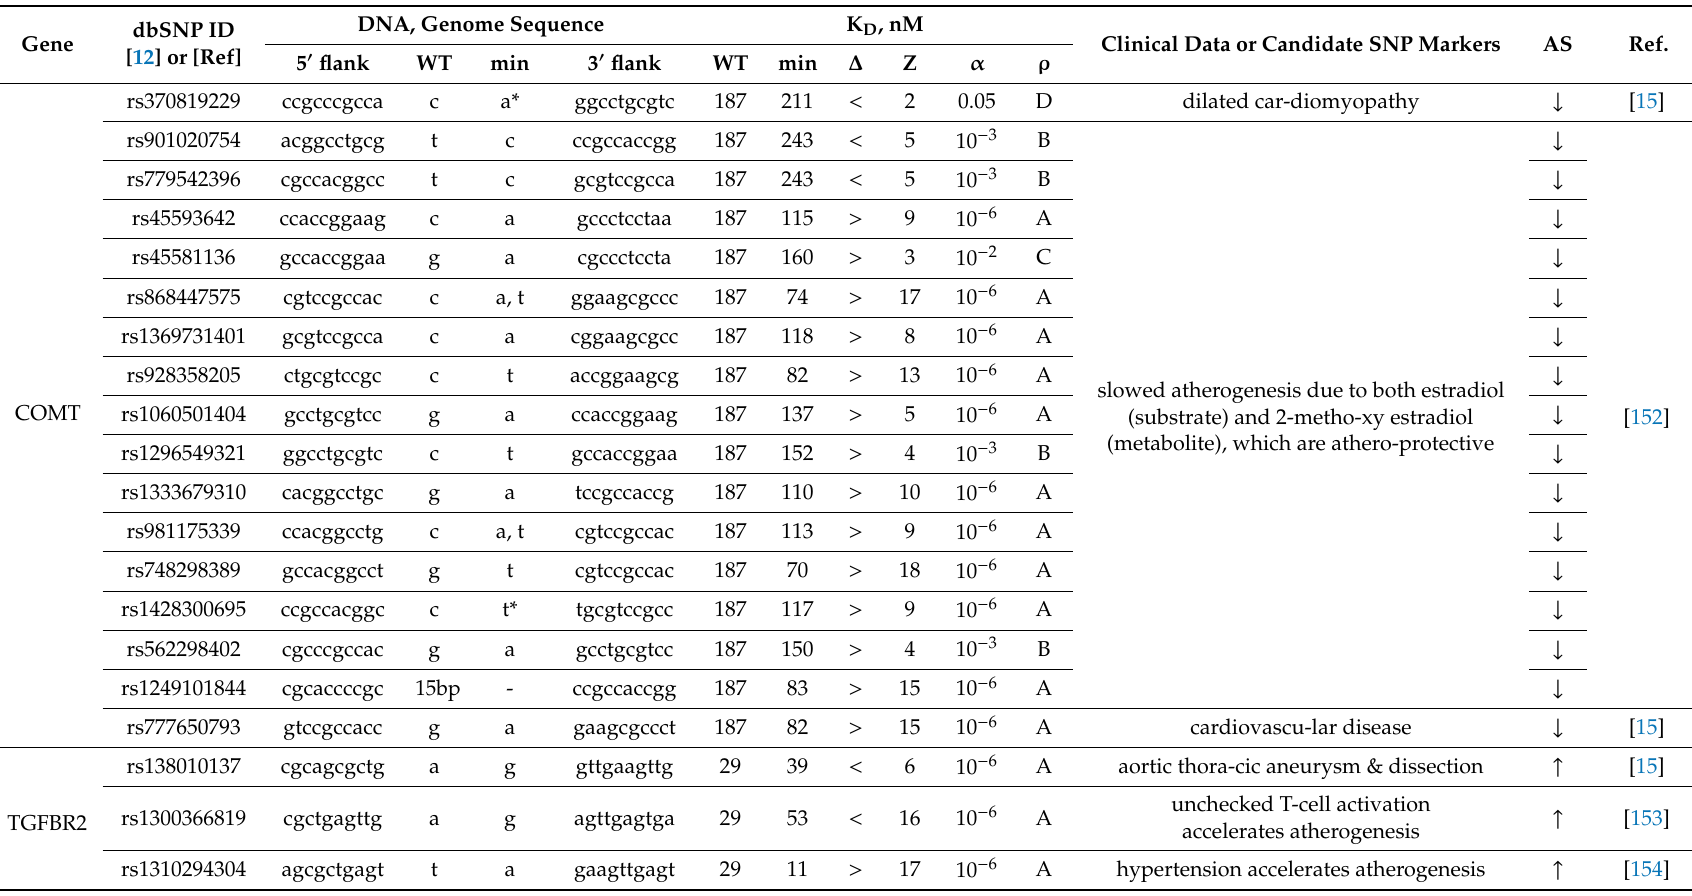
Table 7. Atherogenesis-related candidate SNP markers within the gene promoters in which SNPs of TBP-sites are clinically linked with developmental disorders. Gene